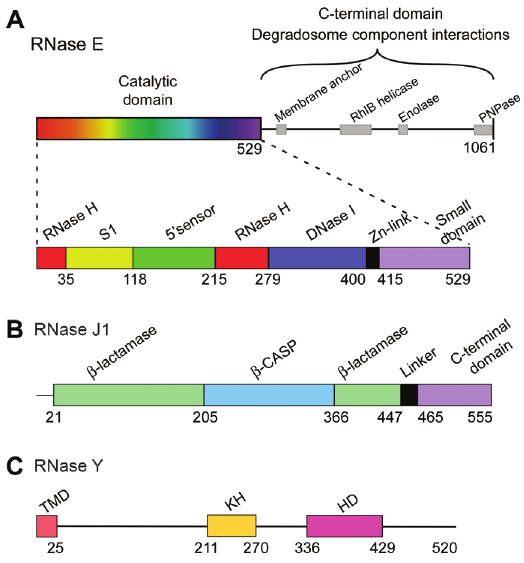
Figure 2 Domain structures of RNases E, J and Y. For a general description, see text. RNase E protein domains estab- lishing interactions with degradosome components are in gray. TMD s transmembrane